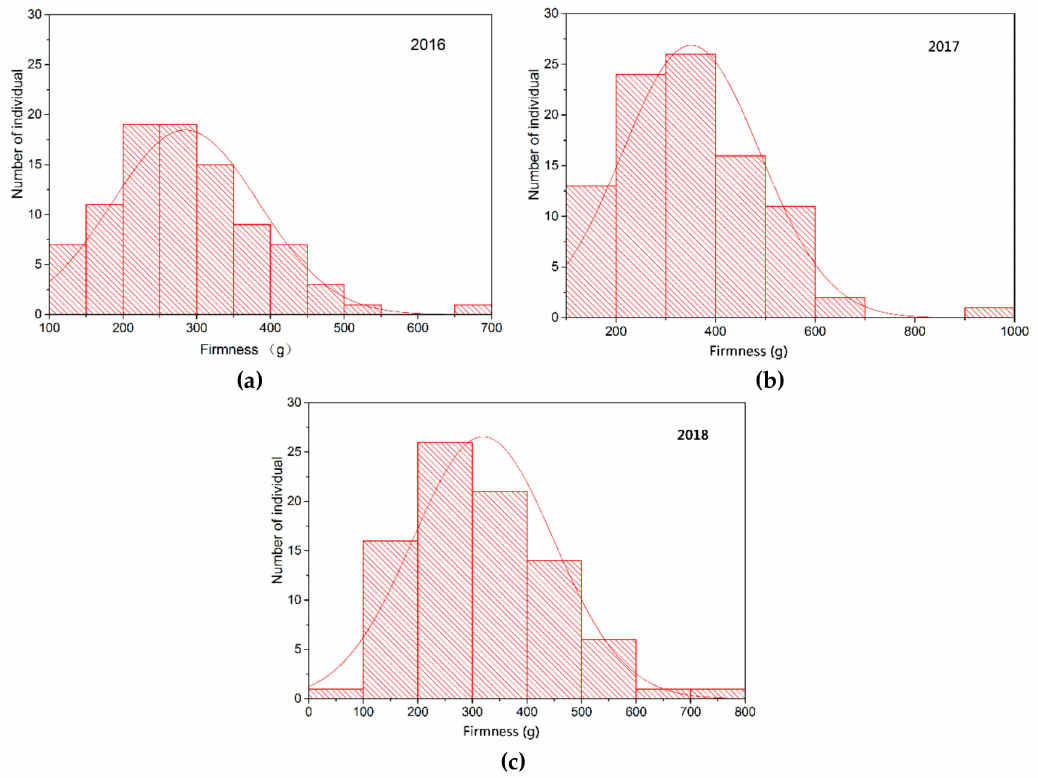
Figure 1. Frequency distribution of berry firmness in the F1 population in ( a ) 2016, ( b ) 2017, and ( c )